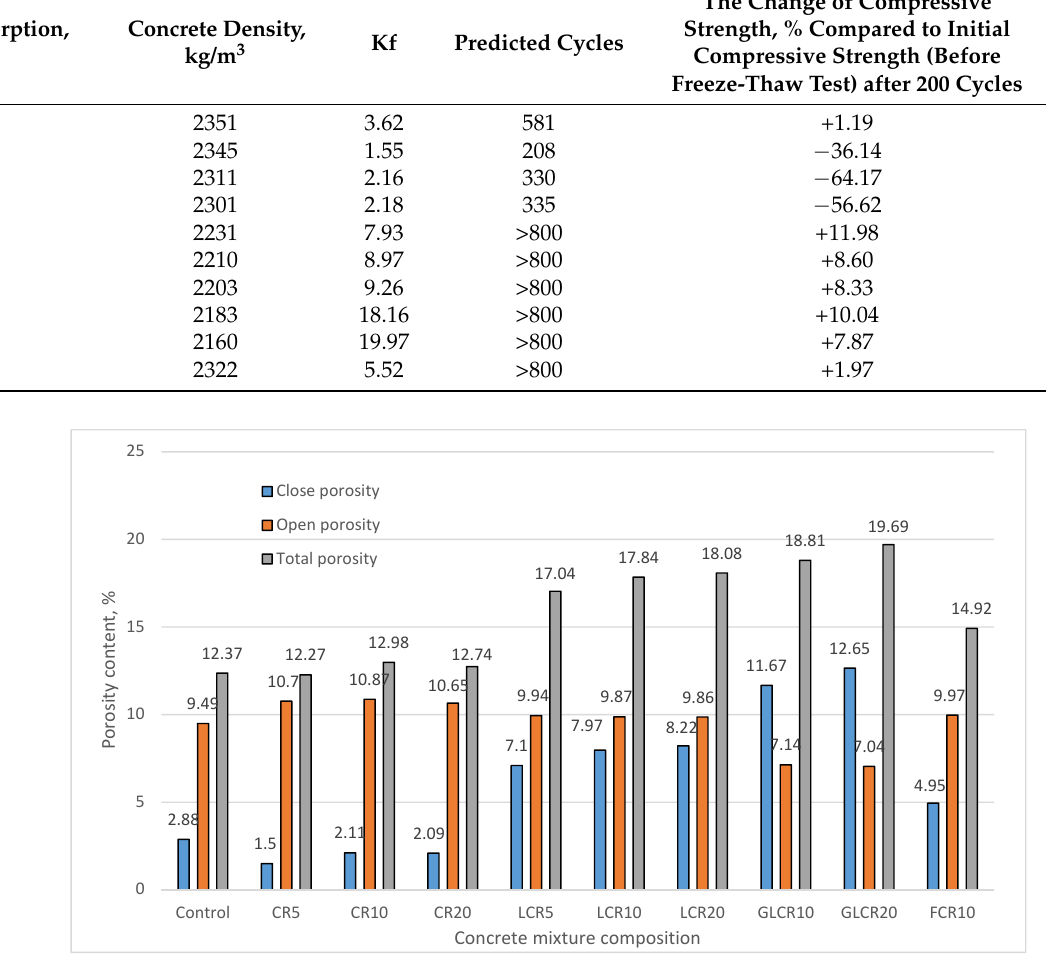
Figure 6. Change in porosity parameters of concrete after water absorption kinetics testing.